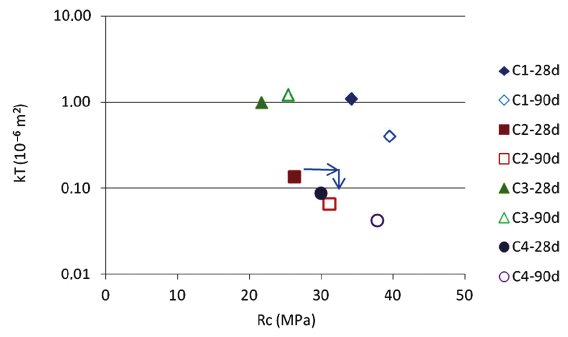
Fig. 16. Compressive strength vs. air permeability (logarithmic